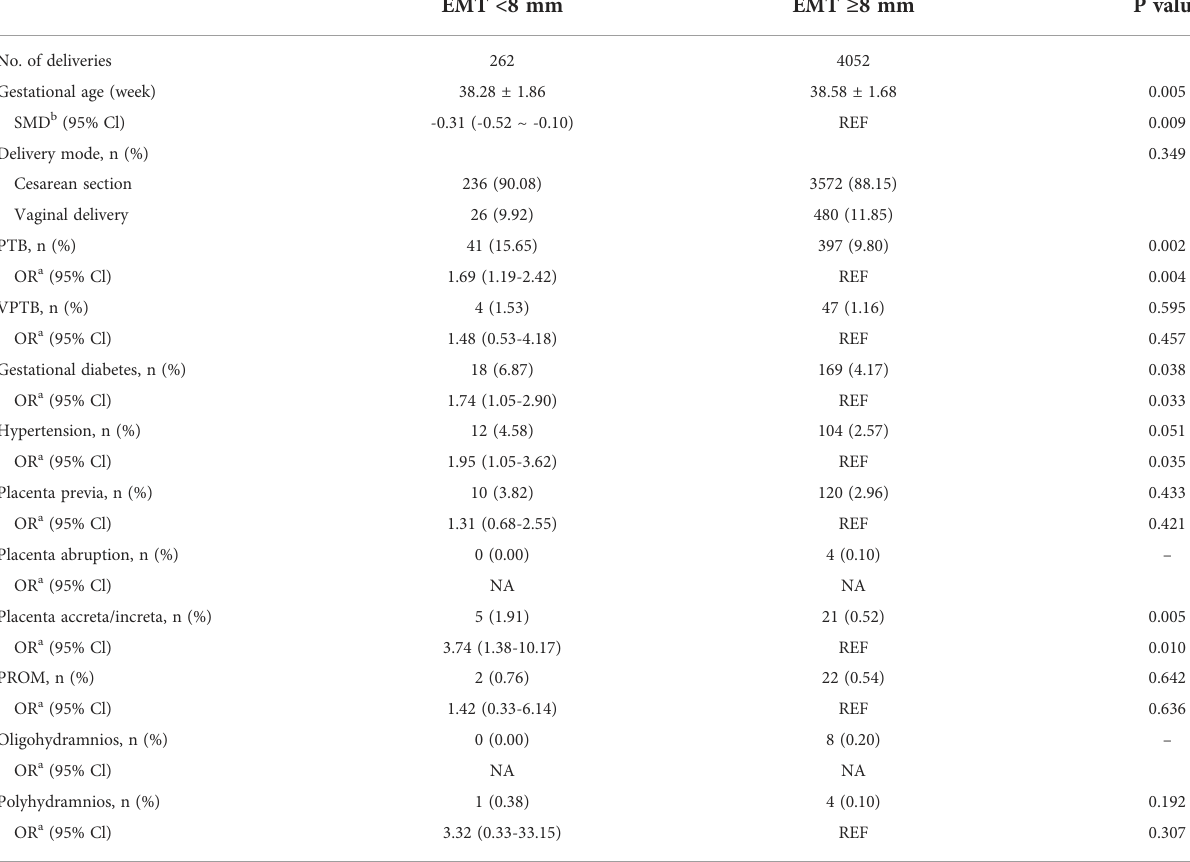
TABLE 2 Maternal outcomes as a function of